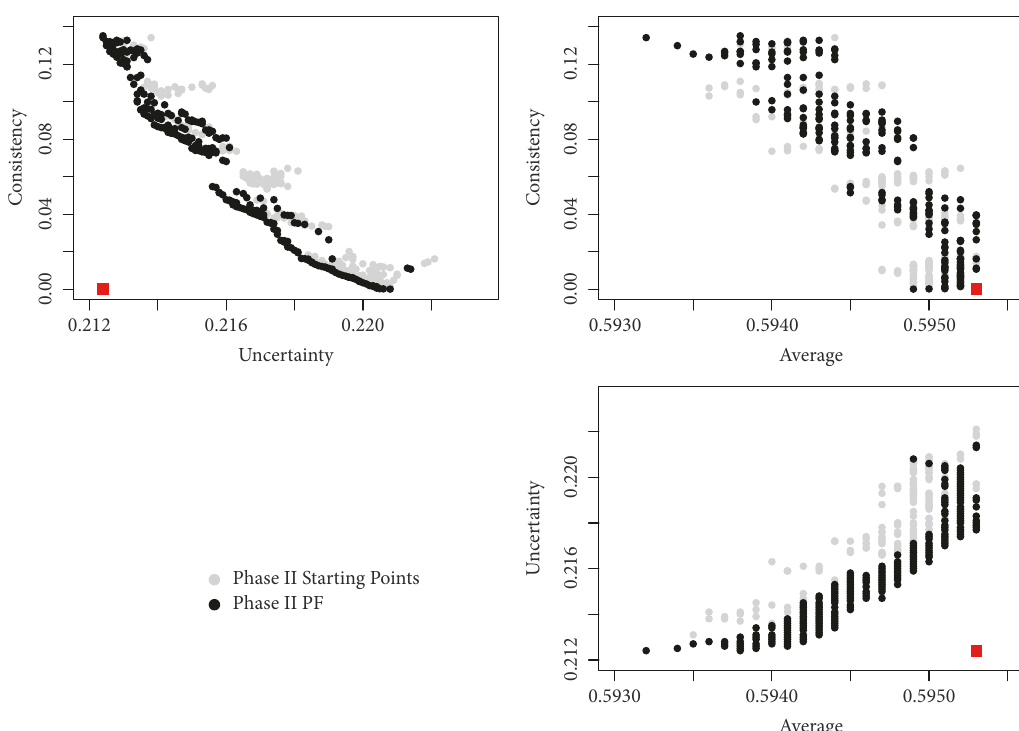
Figure 8: Pairwise scatterplots of Phase II staring points (light gray circles) and Phase II Pareto front (black squares). The square symbol in each plot represents the Utopia point, where both criteria achieve their optimal values.